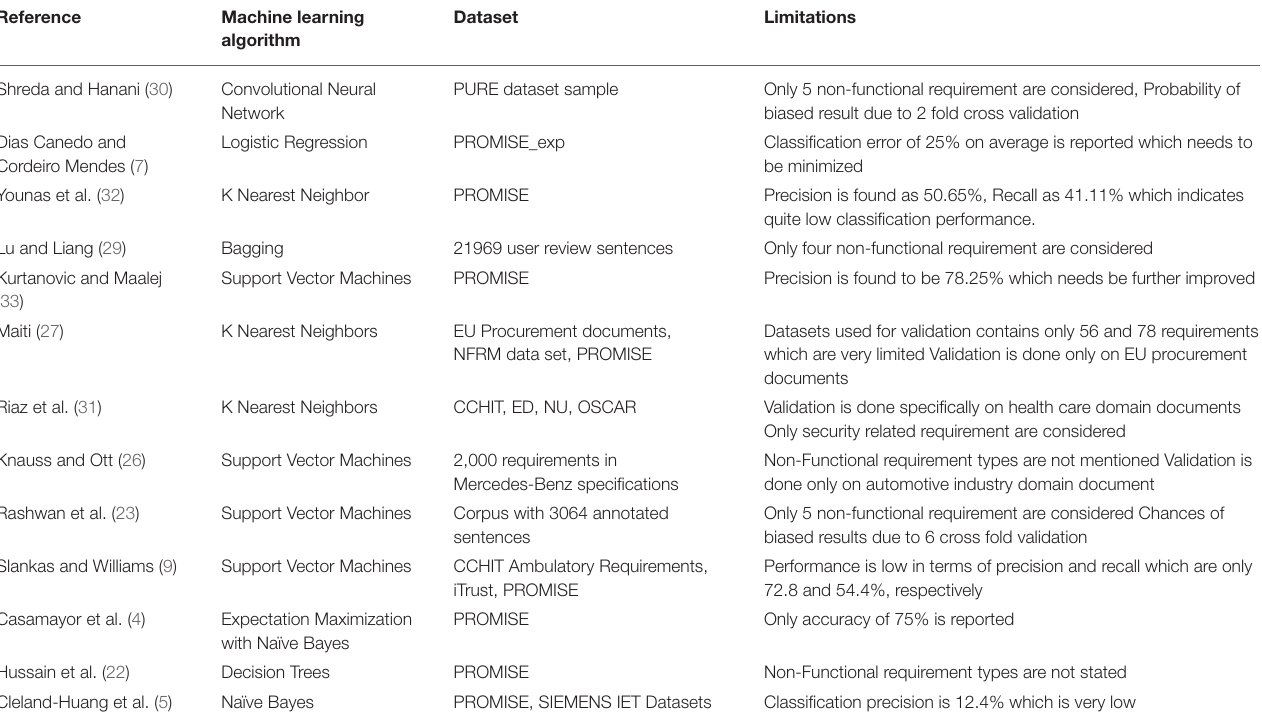
TABLE 1 | Non-functional requirements classification